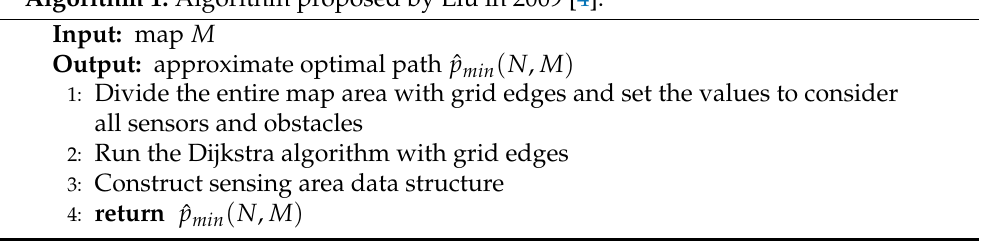
Algorithm 1: Algorithm proposed by Liu in 2009 [4].